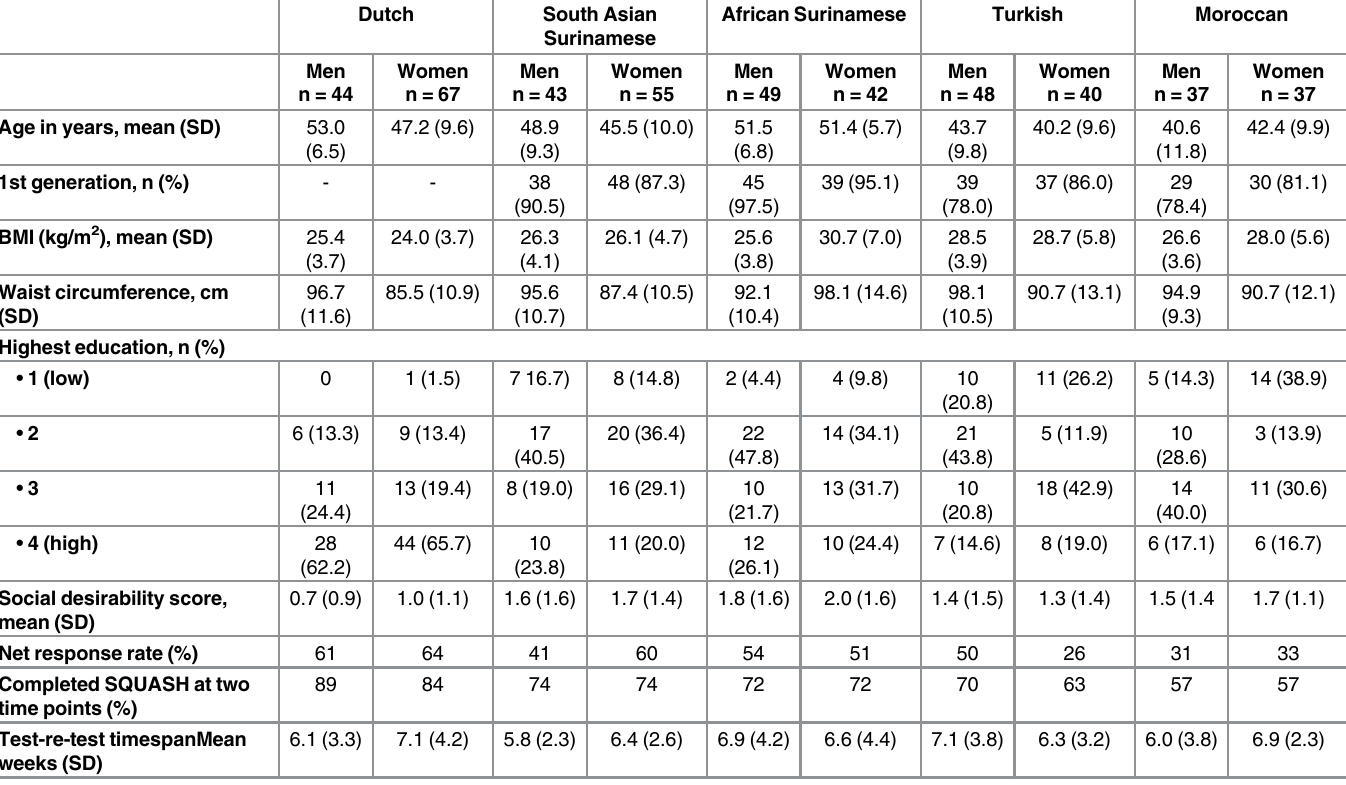
Table 1. Participant